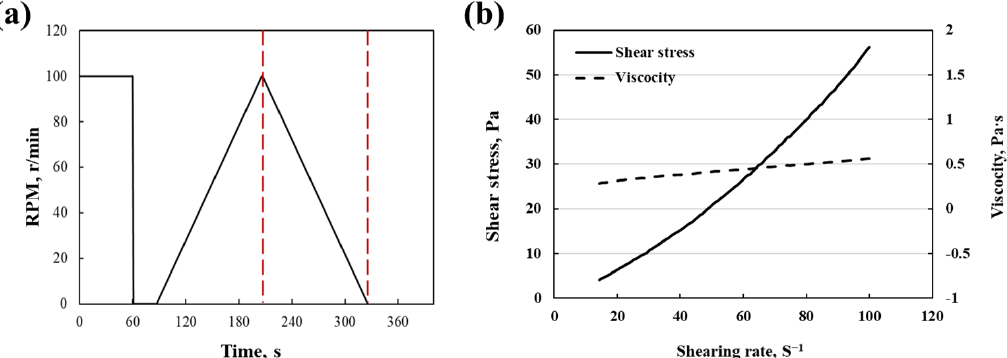
Figure 2. ( a ) Shearing velocity at different times and ( b ) slurry viscosity at different shearing rates.